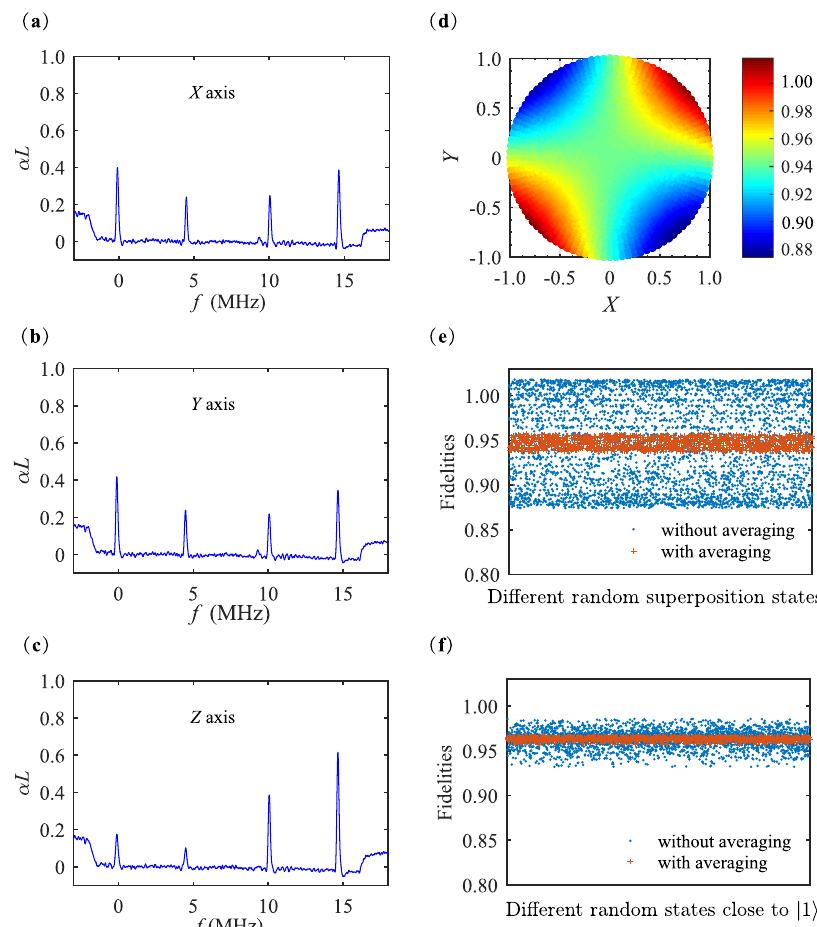
Fig. 4 Tomography results and theoretical investigation on tomography. a – c the experimental tomography results on X , Y , and Z axis of reading out the state after ten transfers between |1 〉 and ð 0 j i (cid:2) i 1 j iÞ = located on a Bloch sphere (top view). e QST fi delity of randomly generated superposition states without and with averaging. f Same as e , but for randomly generated states close to |1 〉